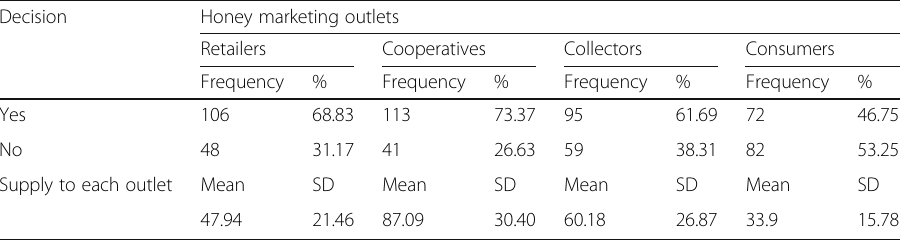
Table 3 Description of honey market outlets